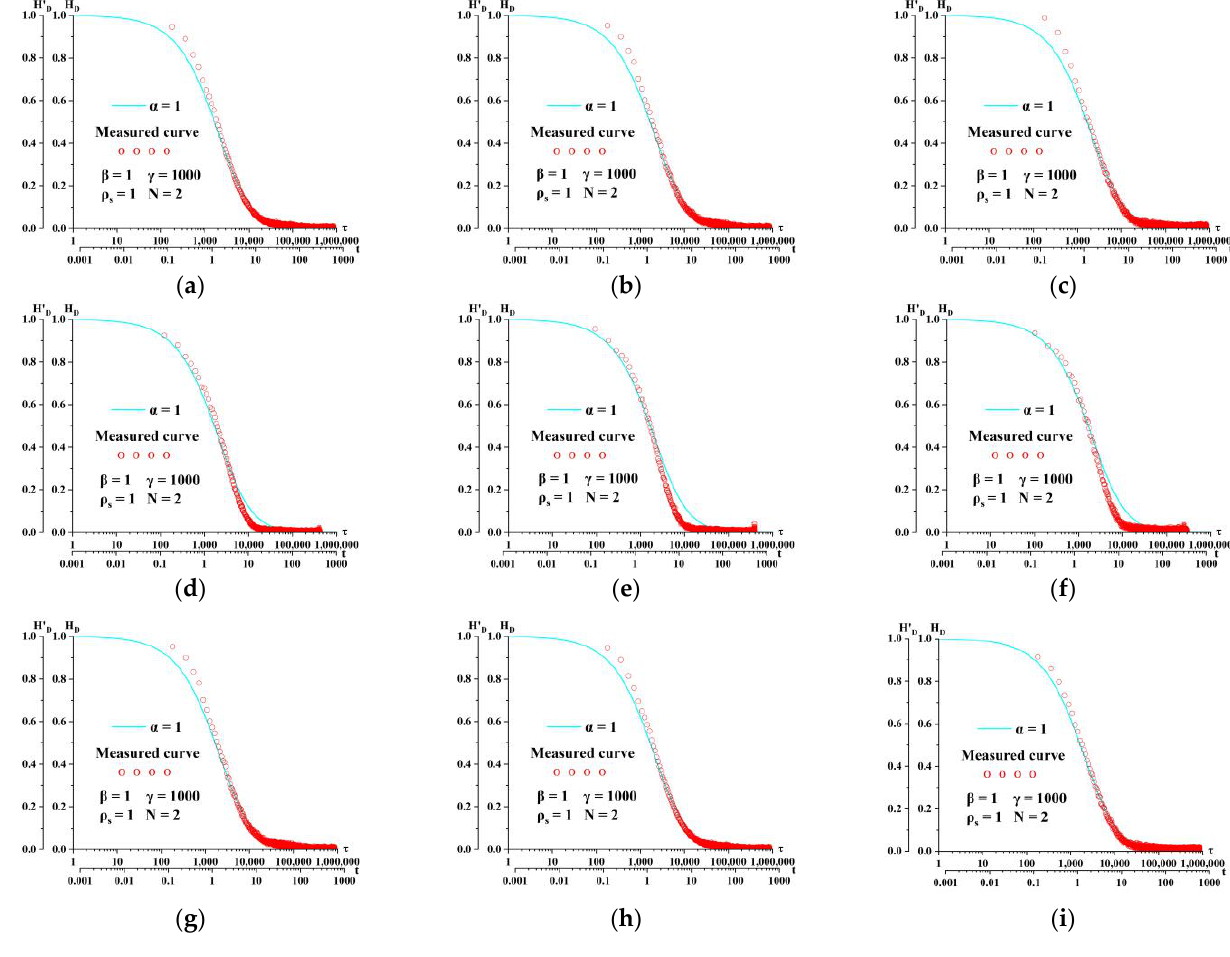
Figure 7. Curve fitting diagram between measured data from slug test and HWS model standard curve under the no well-skin conditions. ( a ) N-Sls1. ( b ) N-Sls2. ( c ) N-Sls3. ( d ) N-Slm1. ( e ) N-Slm2.